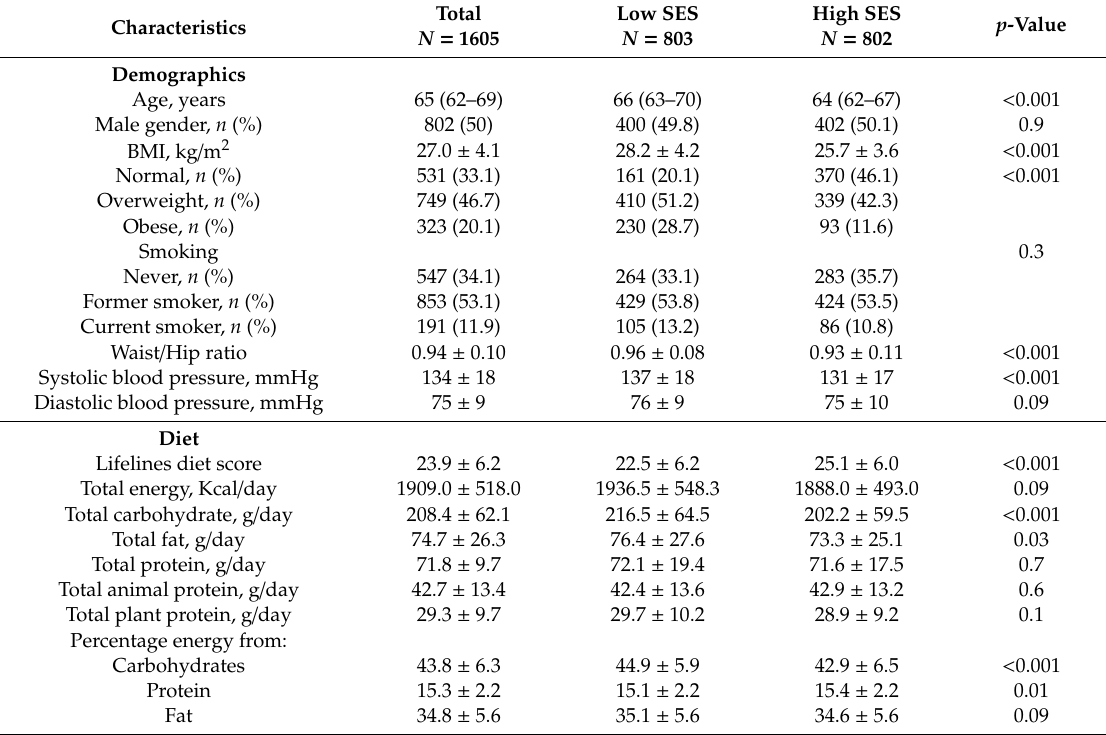
Table 2. Demographics, diet, and vitamin status of the study population.